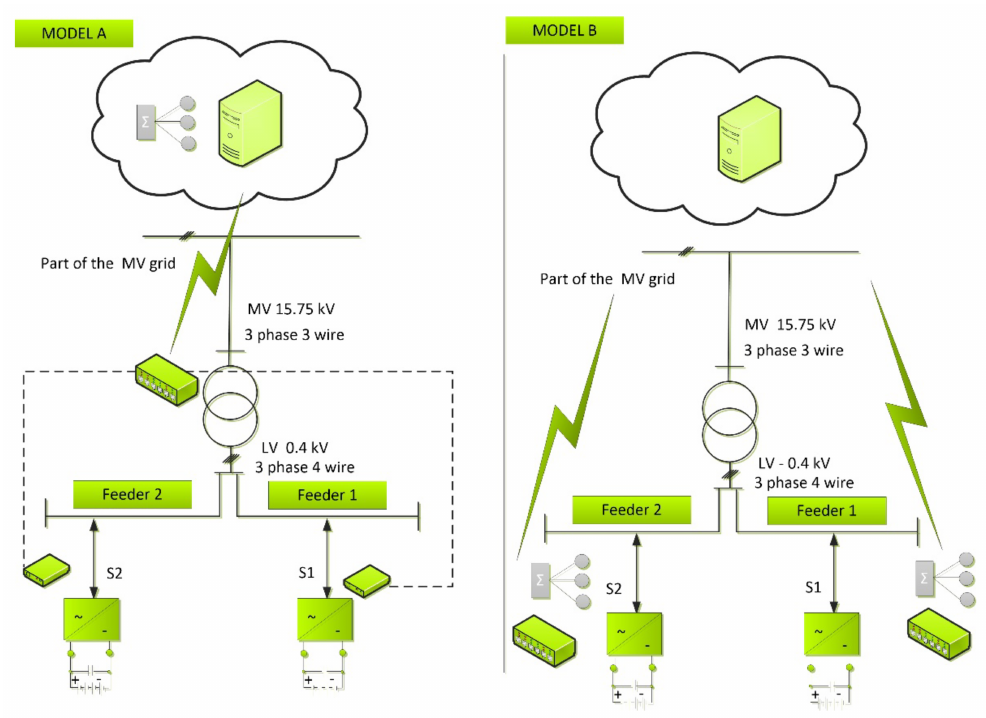
Figure 1. Models for DSO management of actuators and